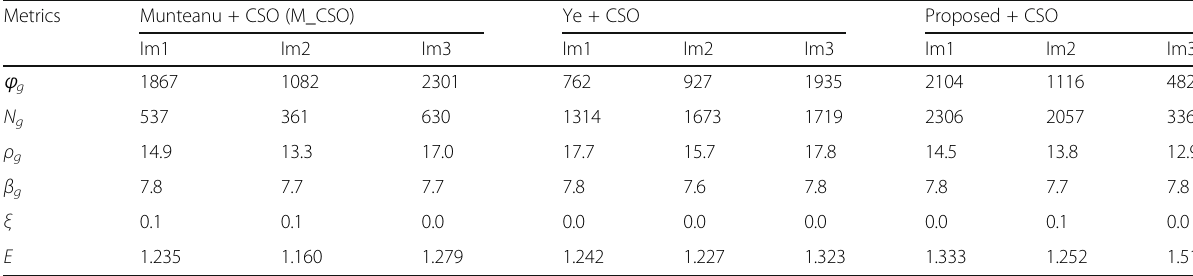
Table 3 Quantitative comparison for different EFs